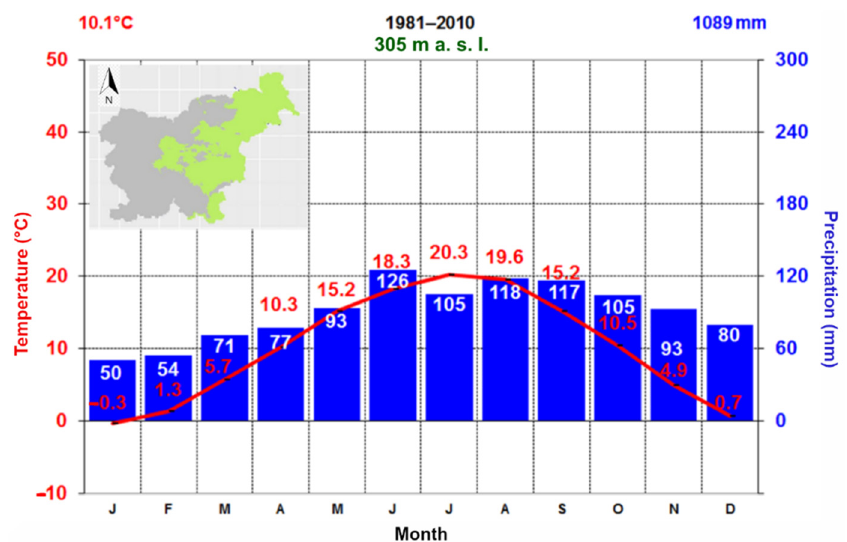
Figure 2. Climograph of the subcontinental climate, climate type at Farm2 (Reprinted with permission from Ref. [22]. Copyright 2016, Katja Kozjek). Numbers in upper corners represent average annual temperature ( left ) and precipitation ( right ).